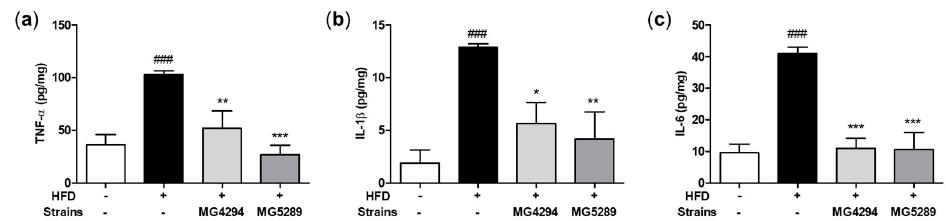
Figure 8. E ff ects of MG4294 and MG5289 on pro-in fl ammatory cytokines in HFD-induced mice. The TNF- α ( a ), IL-1 β ( b ), and IL-6 ( c ) were analyzed by ELISA kits. The data are expressed as mean ± SEM ( n = 6). ### p < 0.001 compared with ND group; * p < 0.05, ** p < 0.01 and *** p < 0.001 compared with HFD-group.